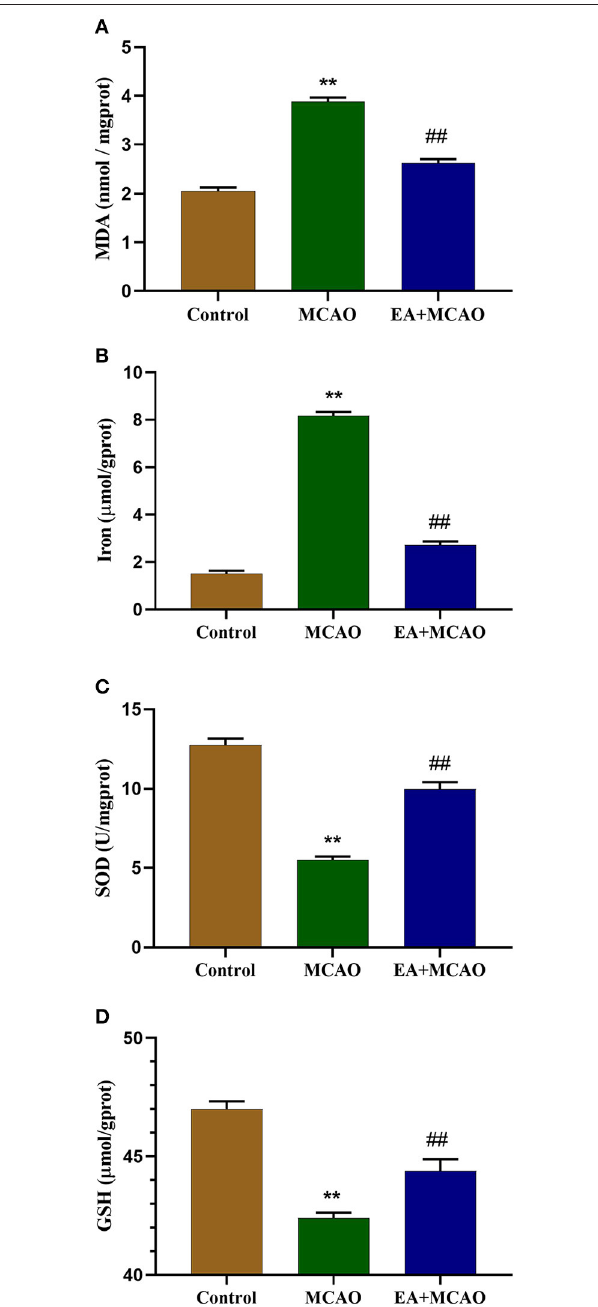
FIGURE 2 | Levels of MDA (A) , total iron (B) , SOD (C) , and GSH (D) in the samples in each group on the 7th day. Results are expressed as means ± SEM ( n = 6). ** P < 0.01, compared with the Control group; ## P < 0.01, compared with the MCAO group.